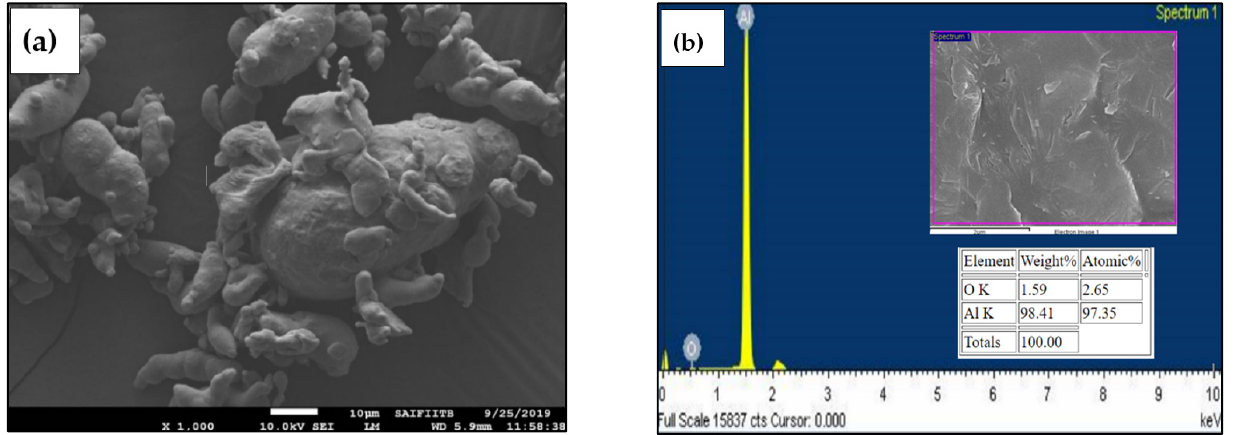
Figure 1. ( a ) SEM micrograph of aluminum powder ( b ) EDS scan of aluminum powder.